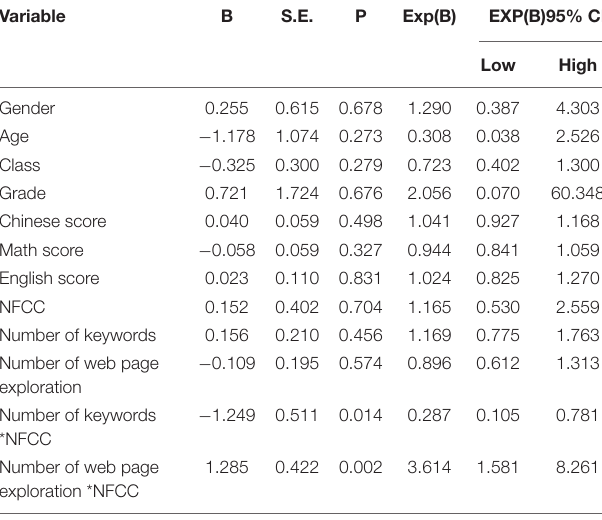
TABLE 2 | Logistic